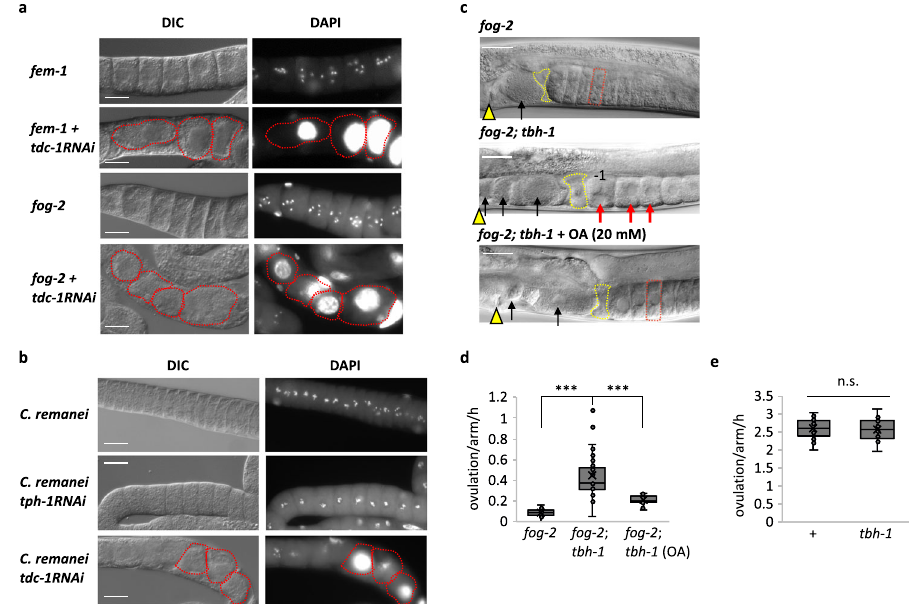
Fig. 3 Maintenance of quiescent oocytes by octopamine in Caenorhabditis females. a fem-1 and fog-2 mutants treated with control or tdc-1 RNAi. Each image represents the 20 − 40 gonad images. Red-dotted circle indicates individual Emo. b A C . remanei female treated with control RNAi or tdc-1 RNAi. tph- 1 encodes a tryptophan hydroxylase. Similar images were observed from 33 gonads for an empty vector, 36 gonads for tph-1 RNAi and 23 gonads for tdc-1 RNAi. c In fog-2 mutants, 6 − 7 quiescent oocytes accumulate (red rectangle). Arrowheads: vulva, yellow polygons: spermatheca. In fog-2; tbh-1 mutants, no quiescent oocytes accumulate. Due to a faster ovulation rate than that of fog-2 mutants, three unfertilized oocytes in the uterus are shown (black arrows). The nucleus of the most proximal oocyte ( − 1) migrated to its cortex, indicating it is undergoing meiotic maturation 23 . Red arrows: activated oocytes. OA (20 mM) rescues the fog-2; tbh-1 phenotype. Two unfertilized oocytes are shown in the uterus due to delay of rescue (black arrows). All animals were virgins observed 10 h after late L4. Similar images were observed from 7 gonads for fog-2 , 16 gonads for fog-2; tbh-1 and 9 gonads for fog-2; tbh-1 + OA. a – c Scale bar = 20 μ m. d Ovulation rates of fog-2 ( n = 28 animals), fog-2; tbh-1 ( n = 71 animals) and fog-2; tbh-1 + OA ( n = 35 animals). Two- sided t -test: p = 2.6 × 10 − 15 (***) for fog-2 vs. fog-2; tbh-1 , 4.5 × 10 − 10 (***) for fog-2; tbh-1 vs. fog-2; tbh-1 + OA. e Wild-type ( + ) ( n = 20 animals) and tbh-1 mutants ( n = 14 animals) show similar ovulation rates in the presence of sperm. (n.s.: not signi fi cant, two-sided t -test: p = 0.76). d , e Boxplots show the median, mean (X), interquartile range (IQR). The upper whisker: the maxima smaller than 1.5 times IQR plus the third quartile, the lower whisker: the minima larger than 1.5 times IQR minus the fi rst quartile. Source data are provided as a Source Data fi oocytes became Emo within 5 h of mating ( n = 12) (Fig. 4d, red arrows). The Emo phenotype of fog-2; tbh-1 was rescued by OA (20 mM) restoring a similar rate of ovulation (18.9 ± 2.2 min/ovulation/arm, n = 11). Taking the delay in